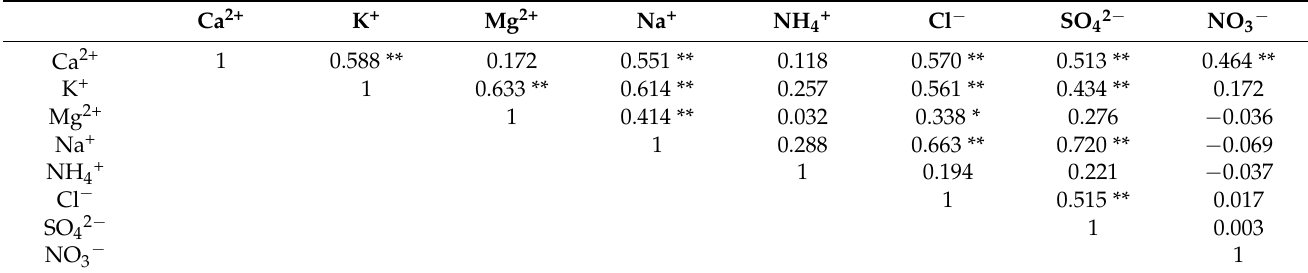
Figure 6. The percentage in different seasons of different ion species deposition fluxes. Table 2. The Pearson correlation of different ion deposition fluxes in